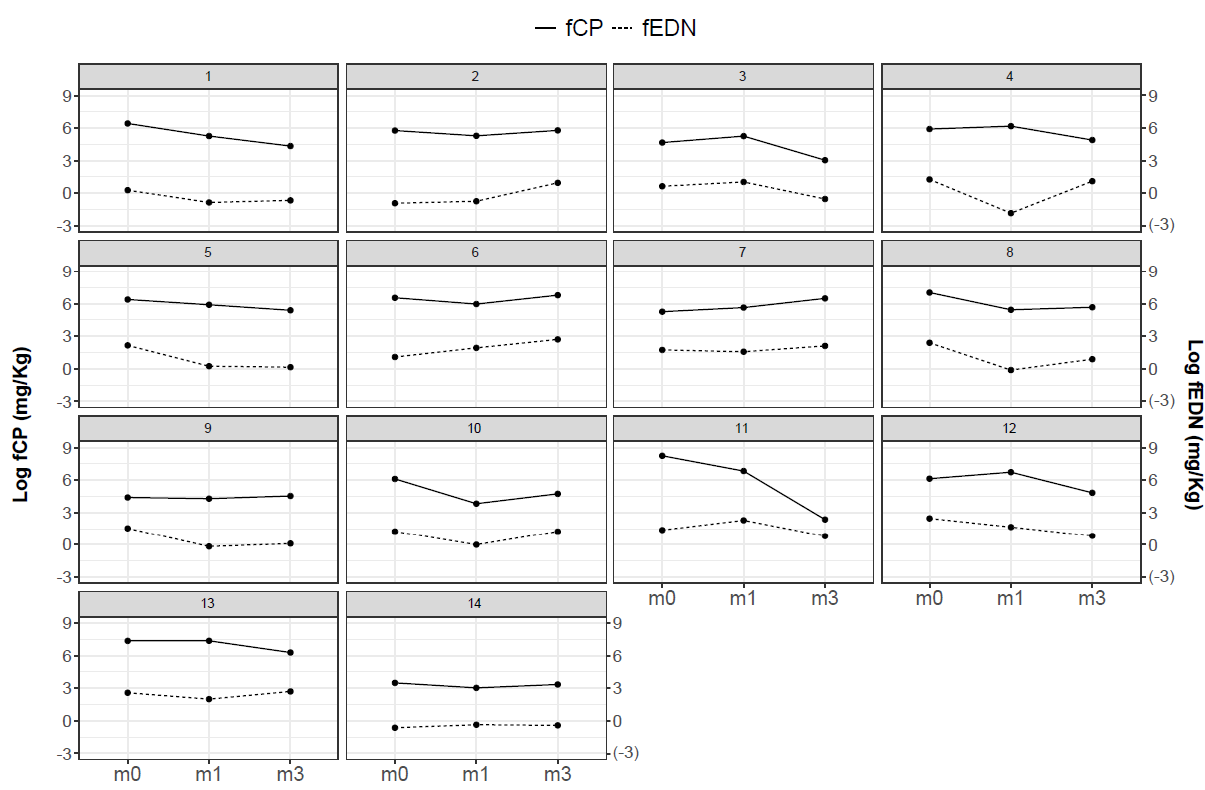
Figure 4. Individual evolution of fCP and fEDN over time in infants of G1 providing 3 samples. The dashed line represents fEDN and the solid line fCP. Variables were log-transformed to improve visualization.